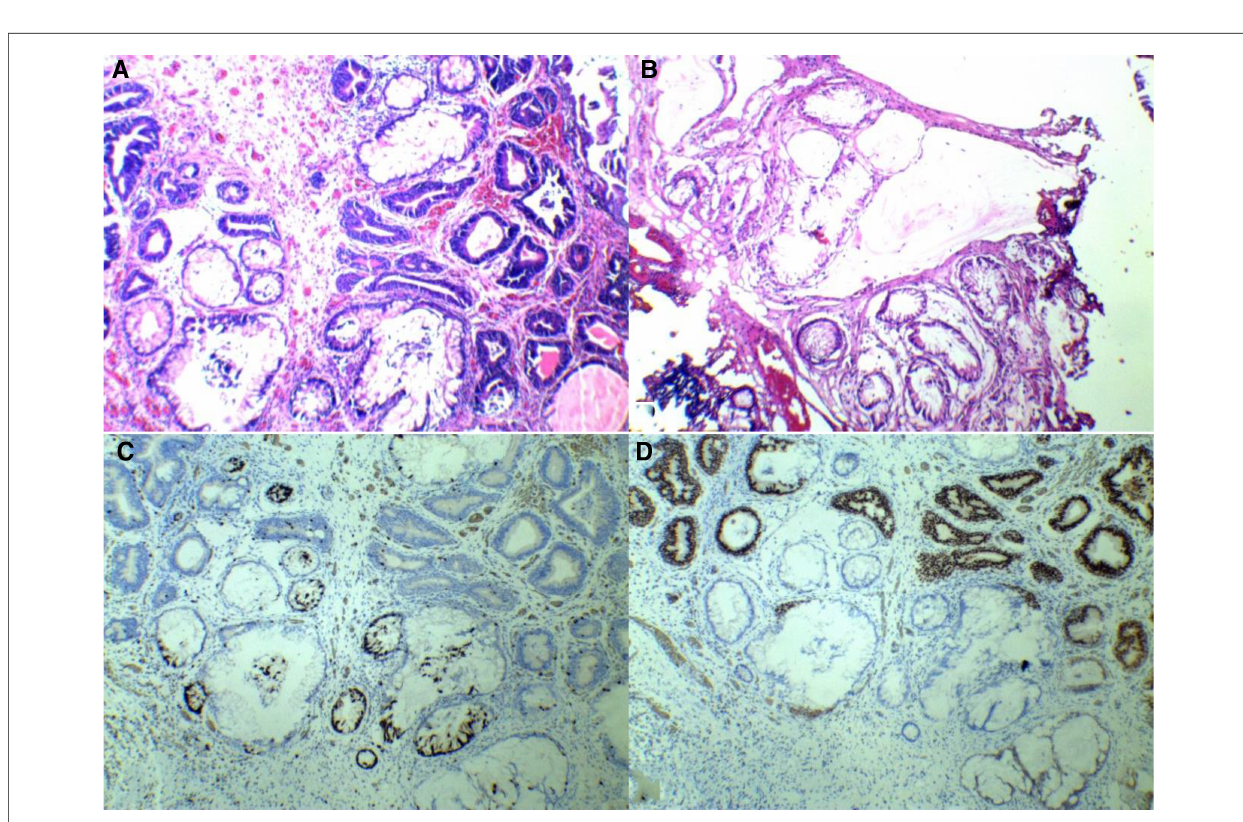
FIGURE 2 Patient 2 ’ s pathology and immunohistochemistry. ( A ) Hematoxylin – eosin staining. ( B ) Hematoxylin – eosin staining. ( C ) CDX-2(+). ( D )